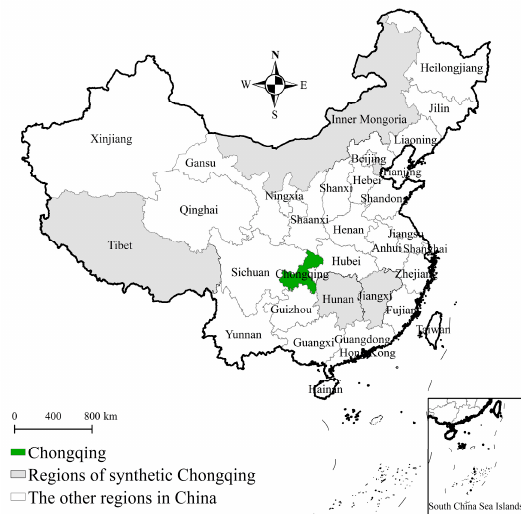
Figure 3. The study area.